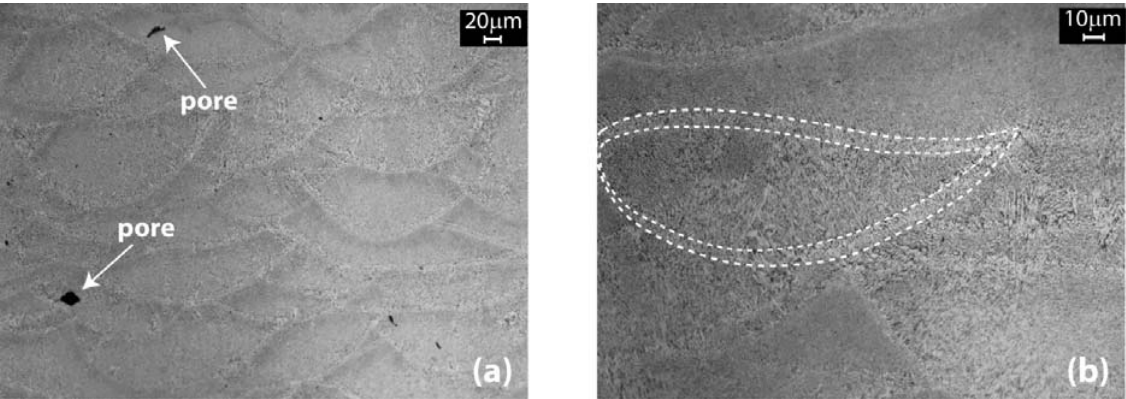
Figure 7. Optical microscope images after Weck’s etching showing: ( a ) the presence of pores and at a higher magnification; ( b ) the shape of a melt pool with its contour